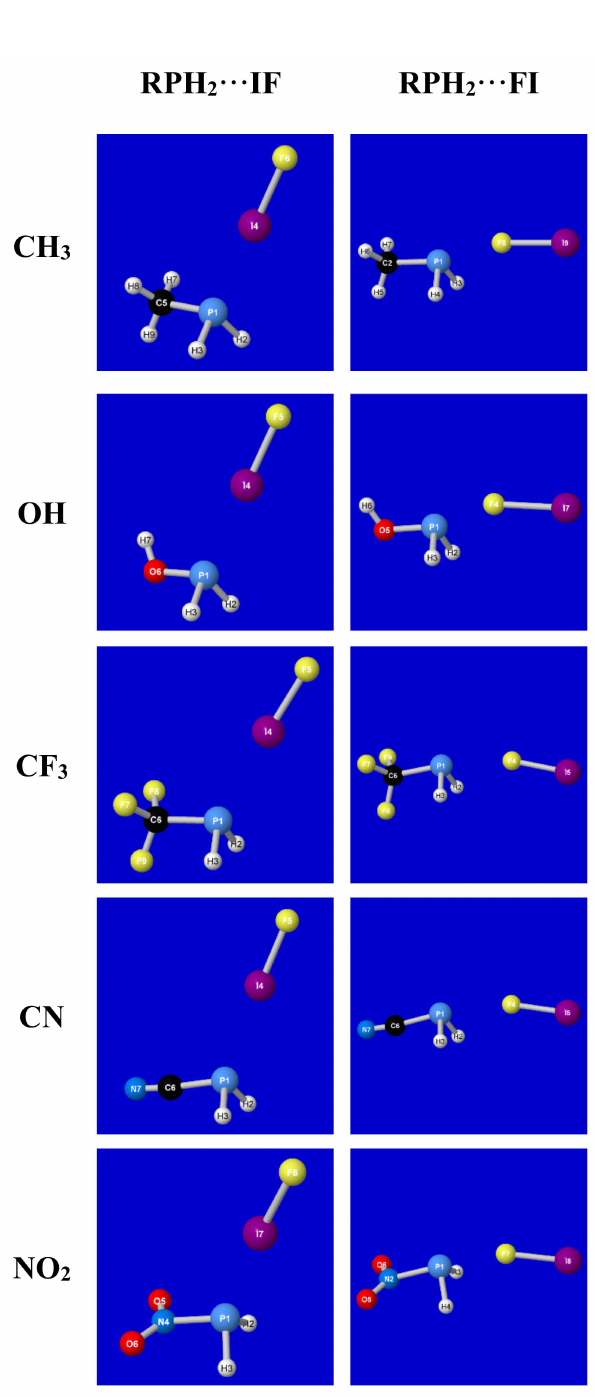
Figure 1. Optimized structures of RPH 2 ··· IF and RPH 2 ··· FI complexes (cf. Table